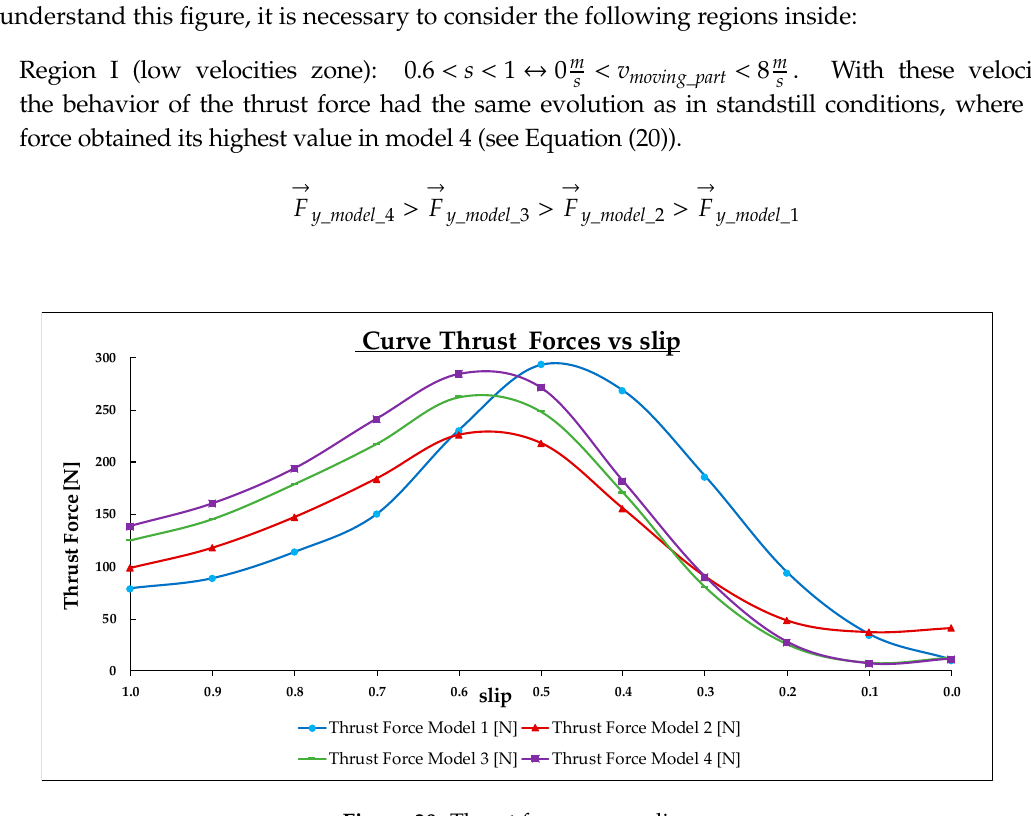
Table 5. Slips values and linear velocities simulated with FEM-3D.